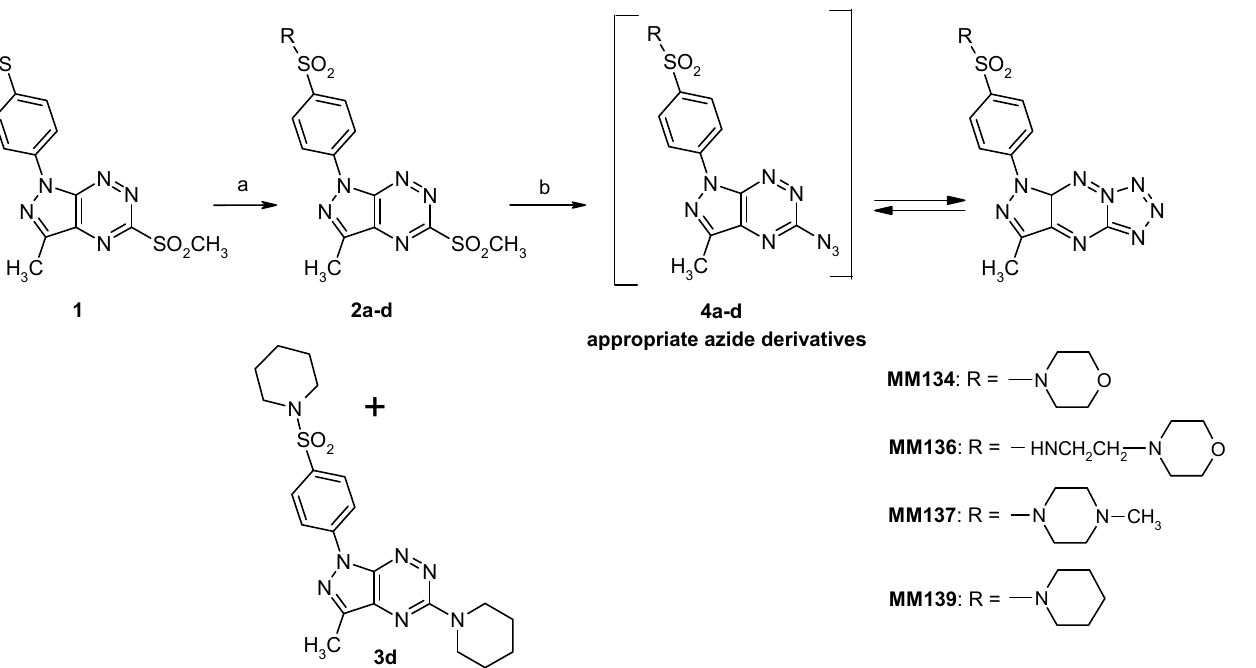
Figure 2. Reagents and conditions: (a) appropriate amine, MeCN, rt, overnight; (b) NaN 3 , EtOH, reflux.